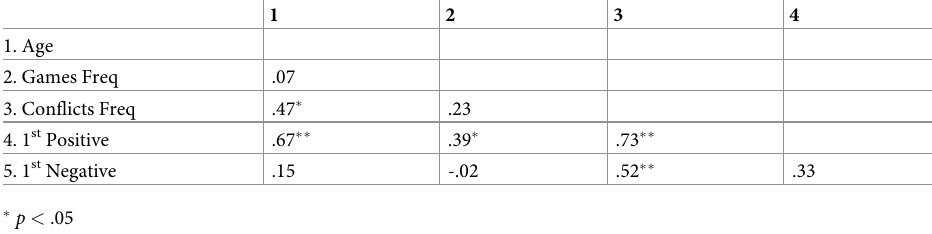
Table 1. Correlation matrix of independent and dependent